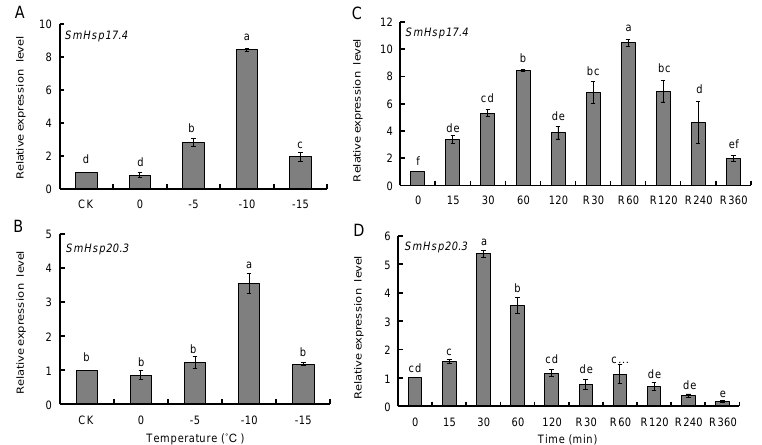
Figure 6. Effect of low temperature extremes on expression of SmHsp17.4 and SmHsp20.3 in over- wintering diapausing larvae. ( A , B ) Exposure to various low temperature (0–15 ◦ C) for 1 h. ( C , D ) Exposure to − 10 ◦ C for various time periods (0–120 min, left side), as well as a 60 min exposure to − 10 ◦ C followed by different recovery time (R30–360 min, right side). Expression level of each treatment was relative to that of the untreated control (CK, 0 min), which was arbitrarily set at 1. Bars represent the means ± SE. The different letters above the columns indicated significant difference by Duncan’s multiple range test ( p < 0.05).